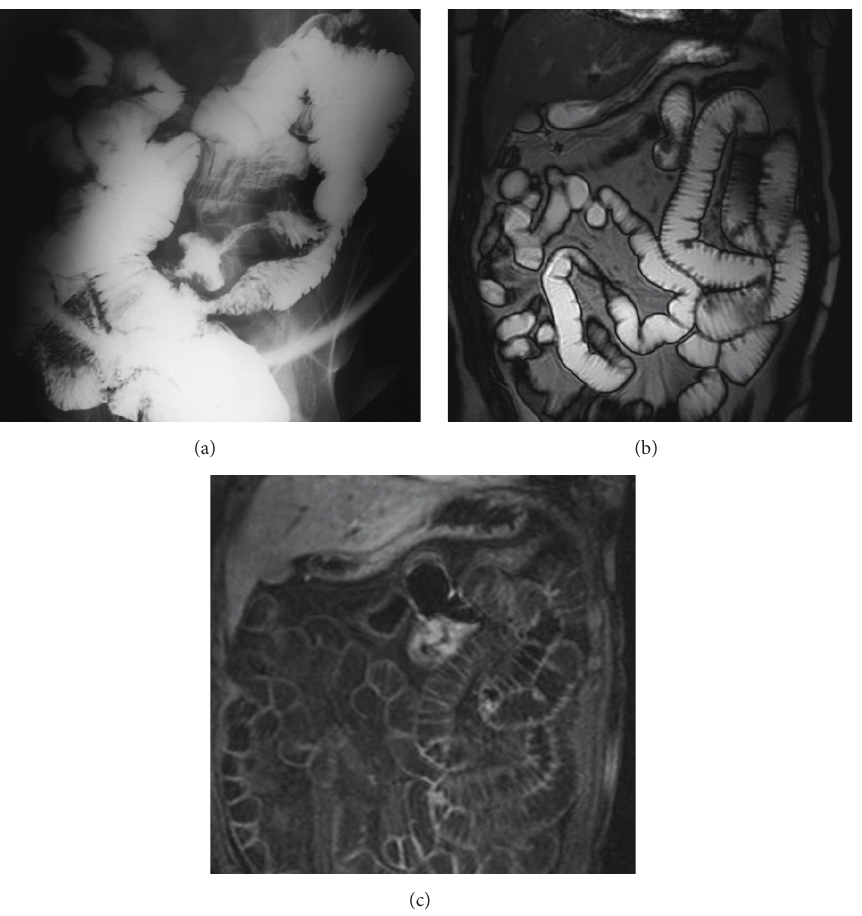
Figure 3: Lesion with infiltrative pattern, protruding into the intestinal lumen, with intense contrast enhancement in the VIBE sequences after the i.v. contrast medium administration (c). No evident lymphadenopathy. Definitive histology: lymphoma.